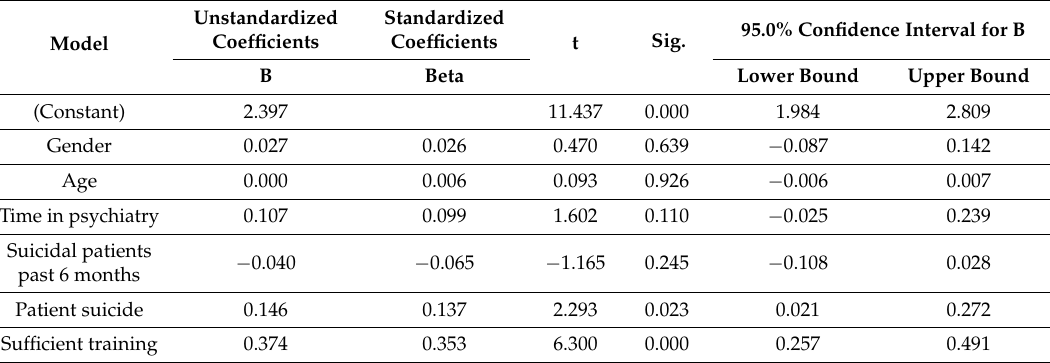
Table 4. Predictors for Job confidence.